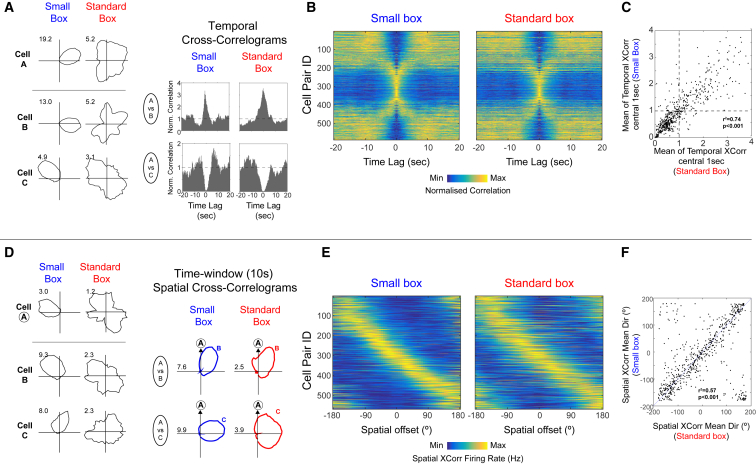
Short-Timescale Temporal and Spatial Couplings between HD Cells Are Preserved Even When Directional Signaling Is Unstable(A) Example polar plots (left) and temporal cross-correlograms (TXCs, right) for 3 HD cells recorded in small and standard boxes.(B) TXCs of all co-recorded HD cell pairs in the small (left) and standard (right) boxes, normalized between their minimum (dark blue) and maximum (yellow) values. Each row in the image shows one TXC, and rows are sorted on the basis of preferred firing direction difference in the small box.(C) Correlation between mean values of the central 1 s of TXCs in the small versus standard box.(D) Example polar plots (left) and time-windowed (10 s) spatial cross-correlograms (SXCs, right) for 3 HD cells.(E) SXCs of all co-recorded HD cell pairs in the small (left) and standard (right) boxes. HD pairs are sorted as in (D).(F) Circular-circular correlation between the mean directions of SXCs in the small versus standard box.